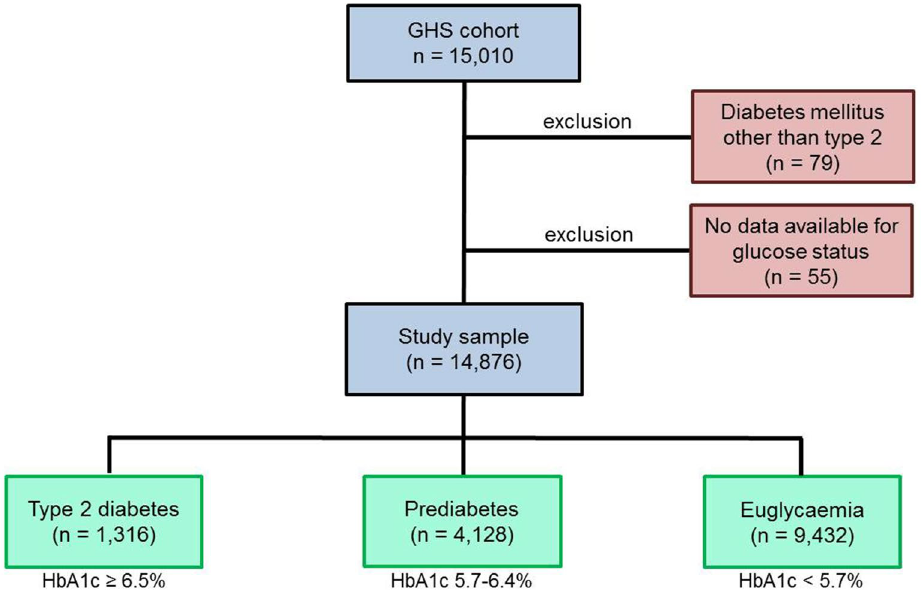
Figure 1. Study sample. Euglycaemia was defined as HbA1c < 5.7%, no T2DM diagnosis by a physician and no intake of diabetic medication. Prediabetes was declared as HbA1c 5.7–6.4%, no T2DM diagnosis by a physician and no intake of diabetic medication. T2DM was present if HbA1c ≥ 6.5 or diagnosis of T2DM by a physician or intake of diabetic medication. Individuals without available data for glucose status and all diabetes types other than T2DM were excluded. In total, 14.876 individuals were included into the study. The blue boxes show the GHS study cohort of which the individuals were included into the present study. The red boxes illustrate excluded participants. In the green boxes the subgroups of the final study sample are displayed. GHS: Gutenberg Health